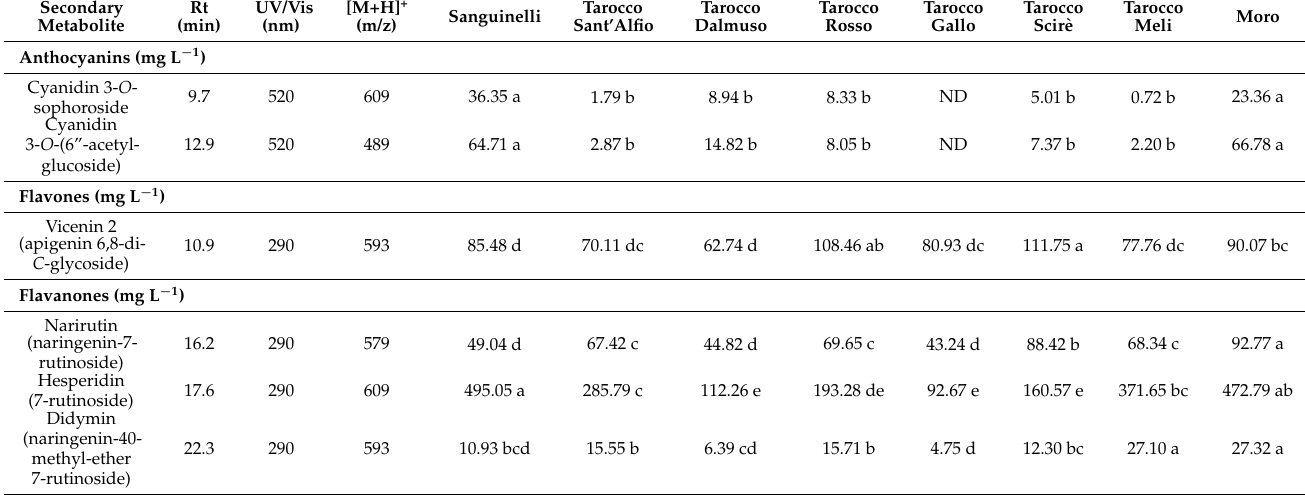
Table 4. Individual content of anthocyanins, flavones, and flavanones in juice of eight blood orange varieties (Sanguinelli, Tarocco Sant’Alfio, Tarocco Dalmuso, Tarocco Rosso, Tarocco Gallo, Tarocco Scir è , Tarocco Meli and Moro) grafted on Citrus macrophylla